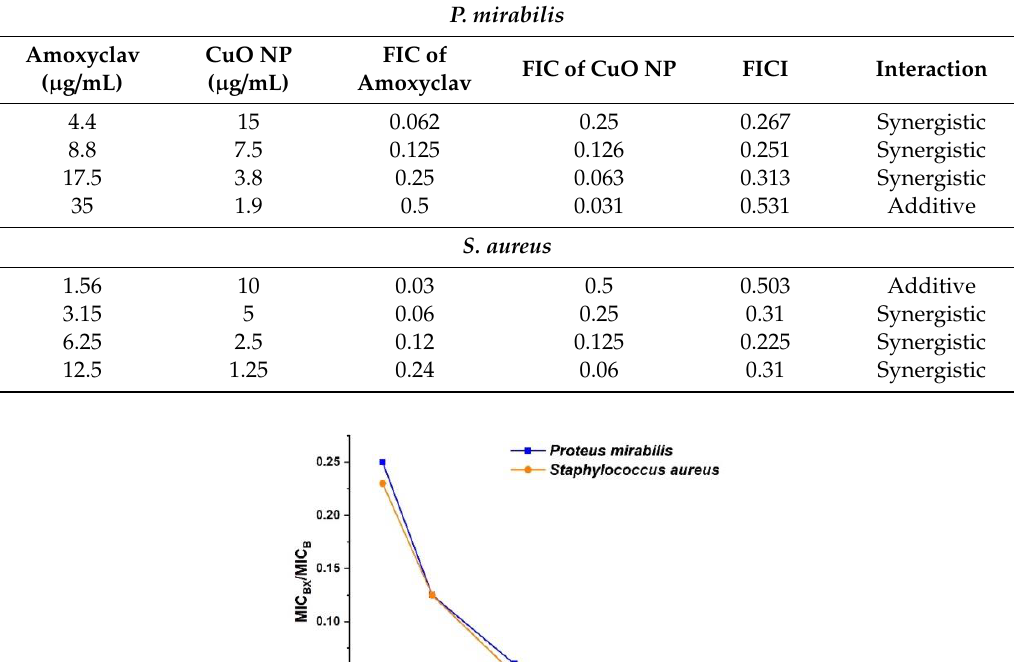
Table 4. Fractional inhibitory concentration index (FICI) of amoxyclav and CuO NPs.